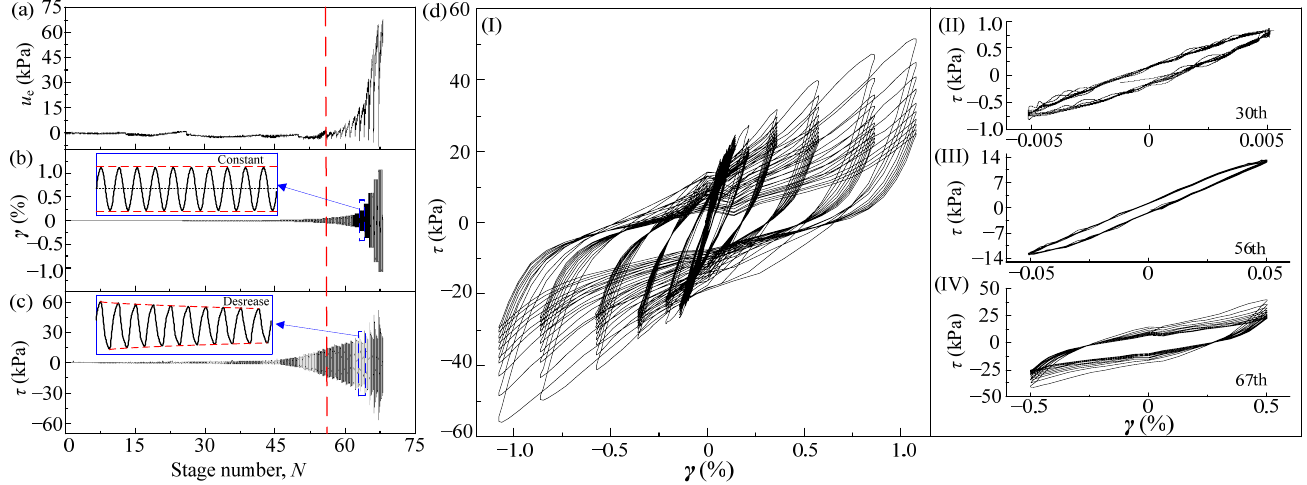
Figure 4. Typical test results of strain-controlled undrained cyclic torsional shear: ( a ) EPWP ( u e ), ( b ) shear strain ( γ ), ( c ) torsional shear stress ( τ ) along with stage number ( N ); ( d ) stress-strain relationship of whole test period and single step.